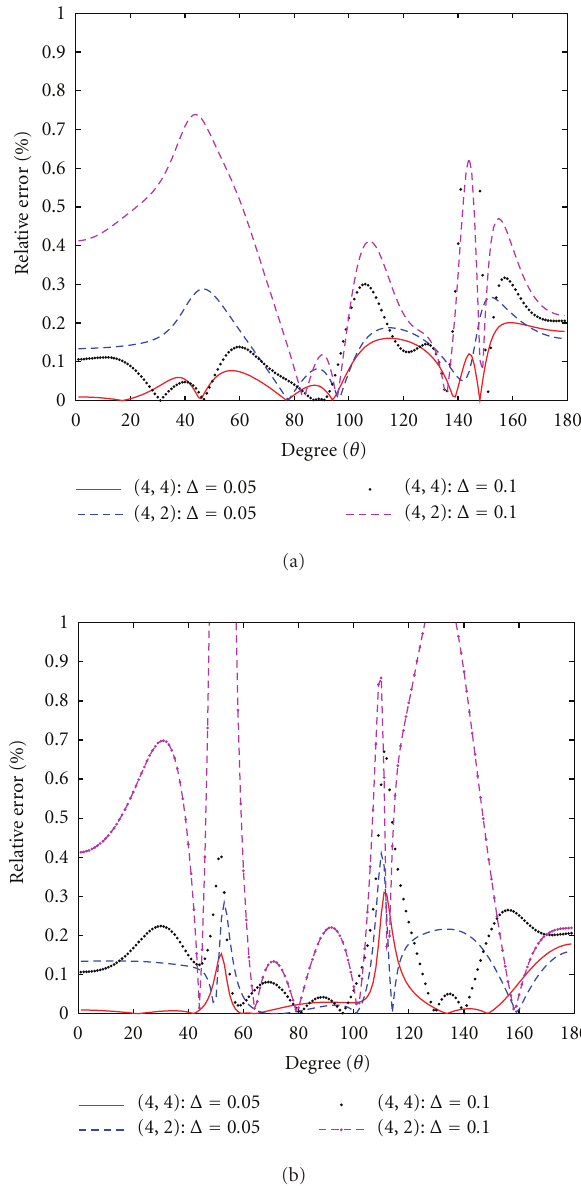
Figure 5: The relative error of computed RCS with di ff erent scheme at CFL = 0.5. (a) E -plane (b) H